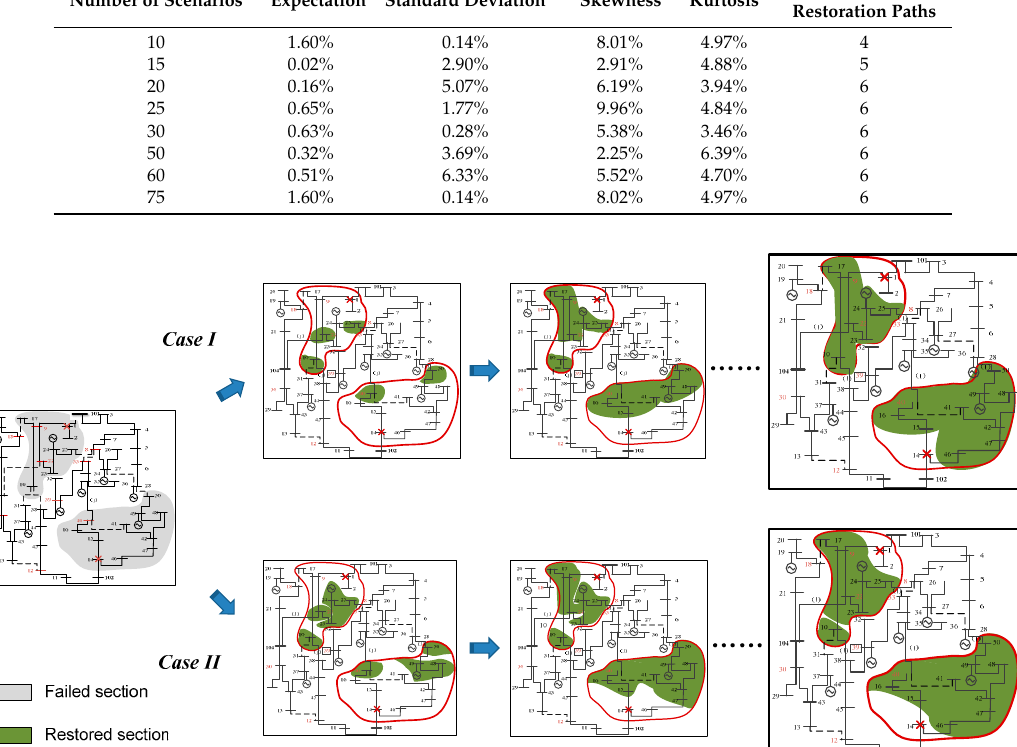
Figure 7. Illustration of load restoration process for case I and case II (our solution).